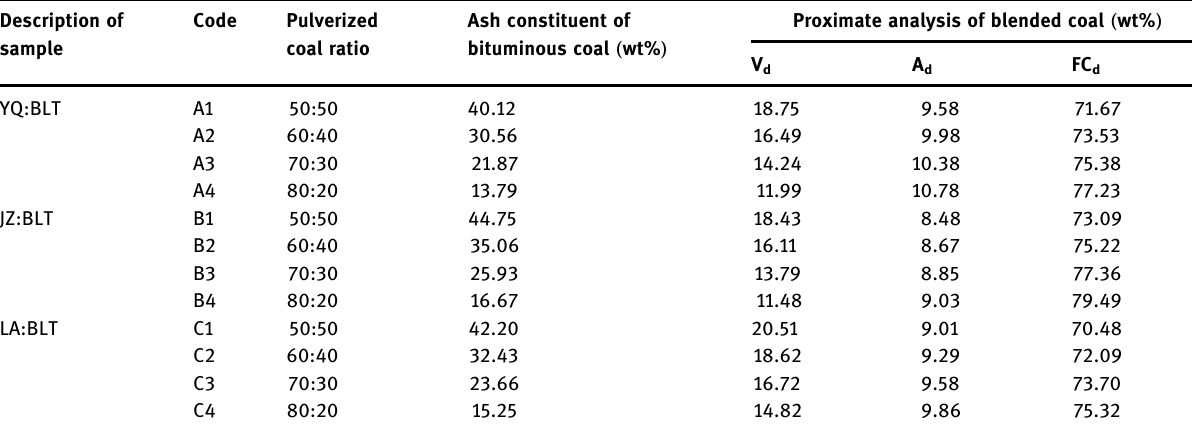
Table 3: Coal blending scheme and proximate analysis Description of sample